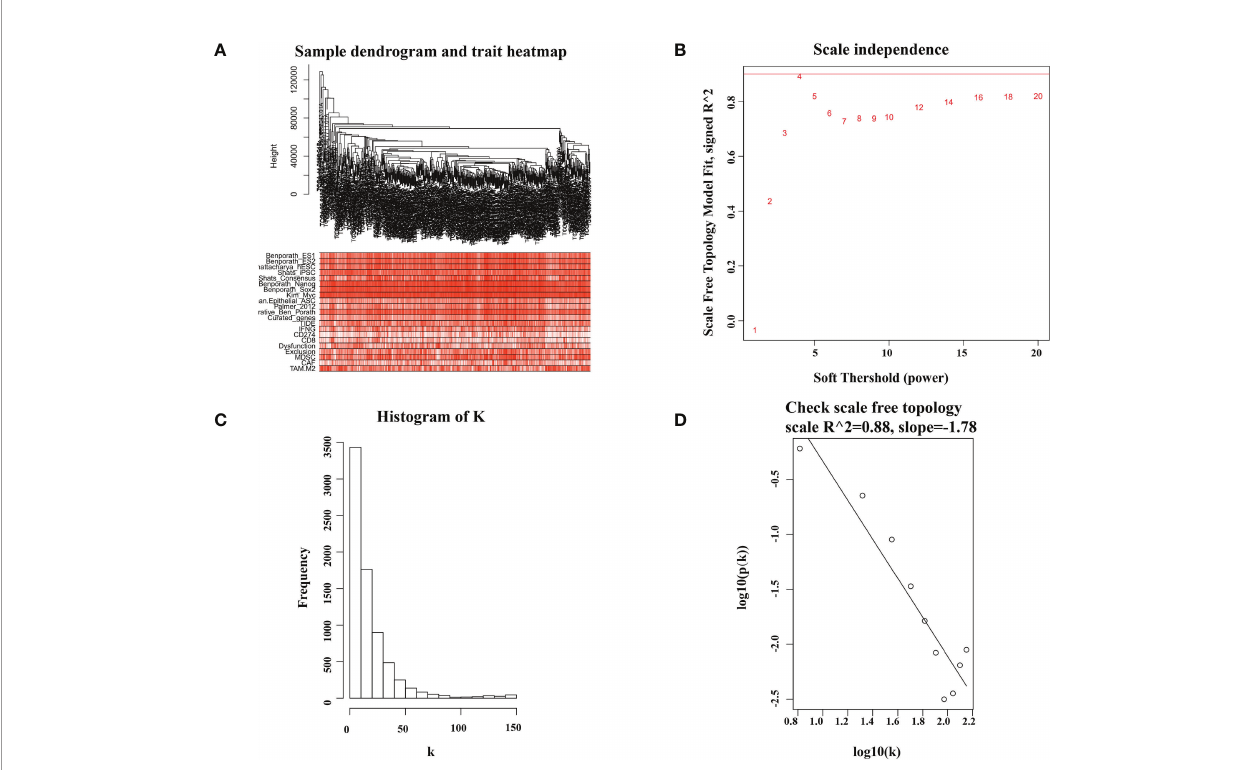
FIGURE 1 | Sample dendrogram and soft-thresholding values estimation. (A) Sample dendrogram and trait heatmap of 507 samples. The upper 12 traits are representative marker of cancer stemness, and the lower 9 traits are common evaluation index of immunotherapy. (B) Analysis of the scale-free index for various soft-threshold powers ( b ). (C, D) The scale free topology when b =